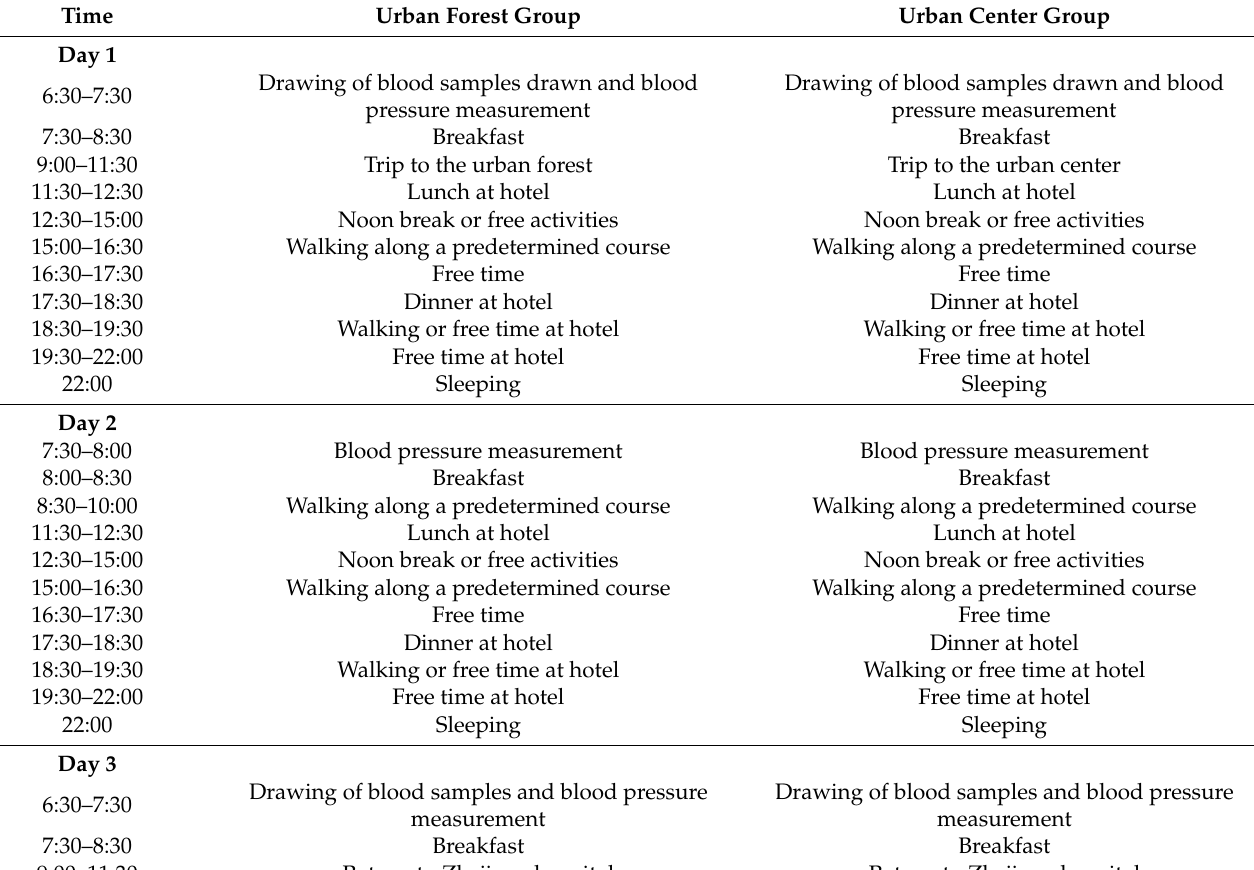
Table 1. The experimental procedure for participants in the urban forest and urban center groups. Urban Forest